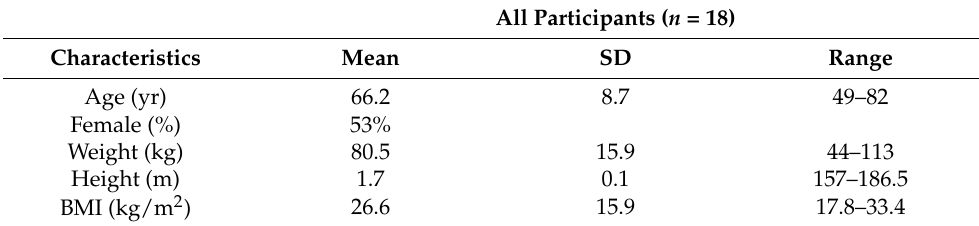
Table 1. Characteristics of participants.